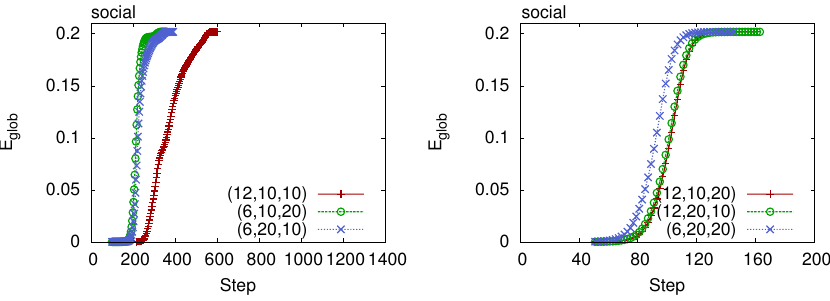
Figure 15. Same cost configurations for VirtualTourist, C s = 1200 ( left panels ) and C s = 2400 ( right panels ), word of mouth model . For each cost C s , three configurations are then considered. In all experiments, the configuration that performs better is the one that has fewer mermaids and higher attractiveness (or equivalently that last more). In accordance with the results of accelerated analysis with no mermaids (Figure 7), random and social rules attain the target efficiency in fewer steps than the aristocratic rule.